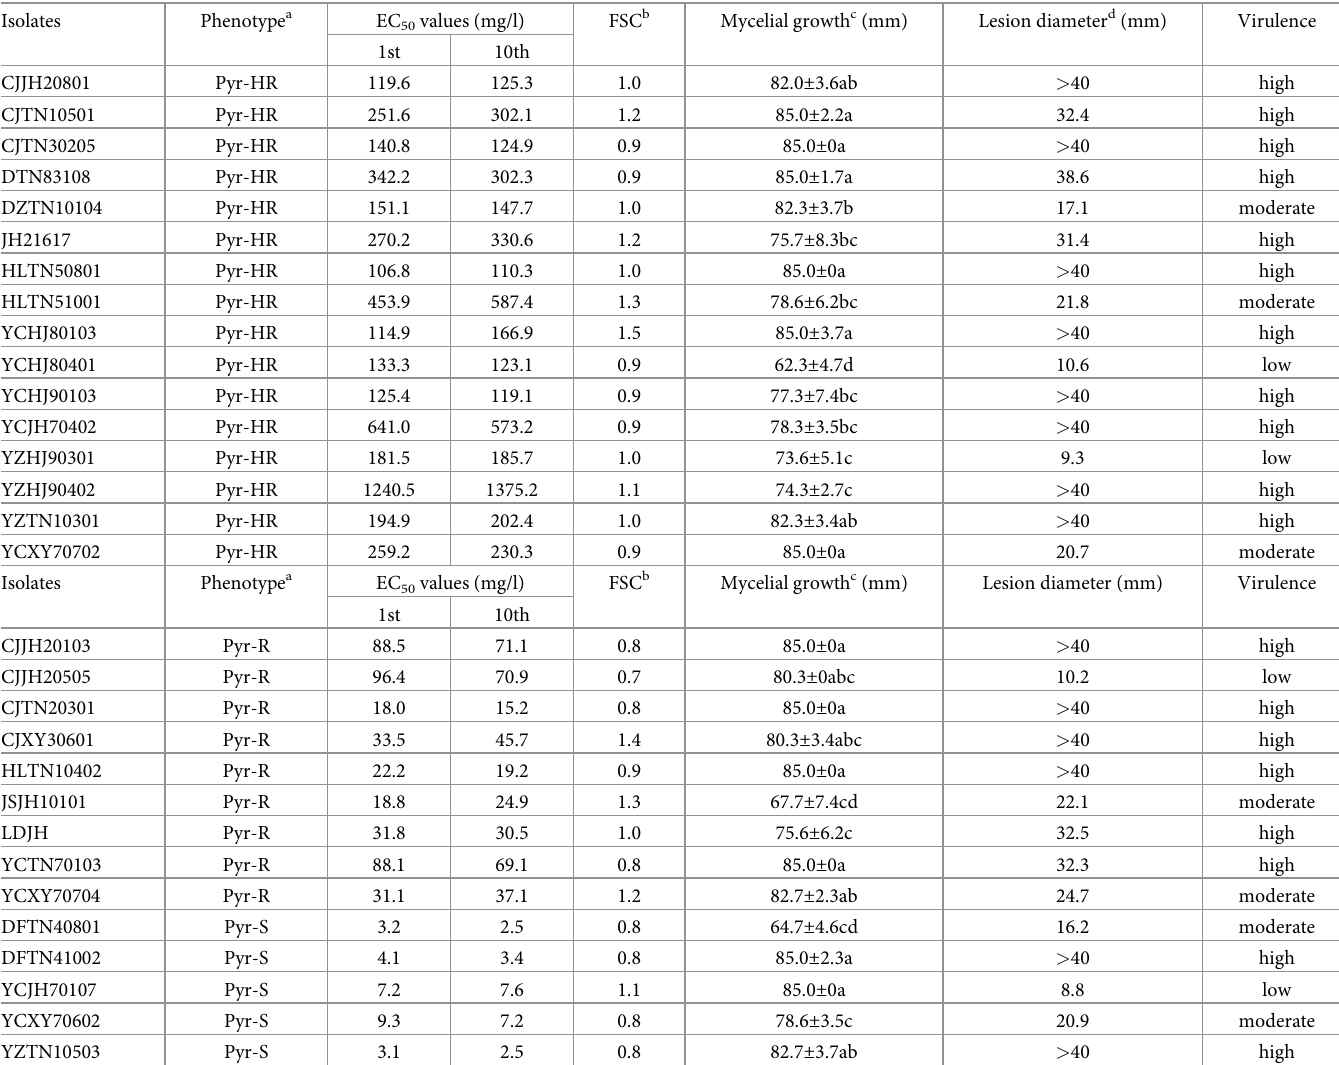
Table 1. Resistance stability, mycelial growth and virulence in vitro for isolates of Lasiodiplodia theobromae differing in fungicide resistance.